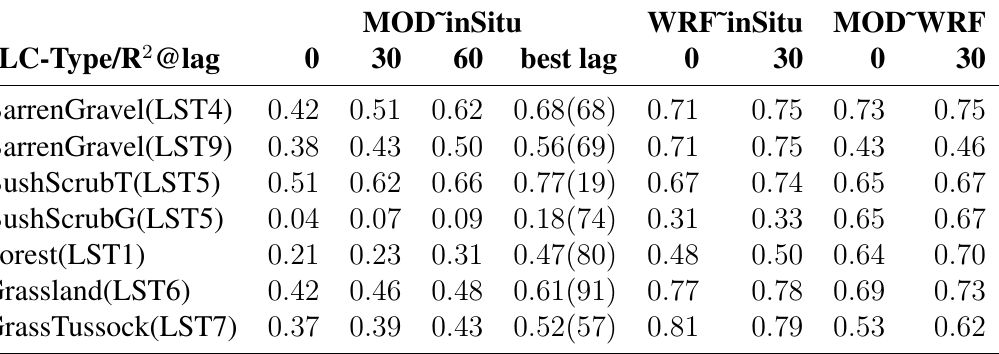
Table 5. Regression R 2 statistics over 5 LC types, including the maximum R 2 values achieved with various time-lags (minute). Time-lags were applied in a range of